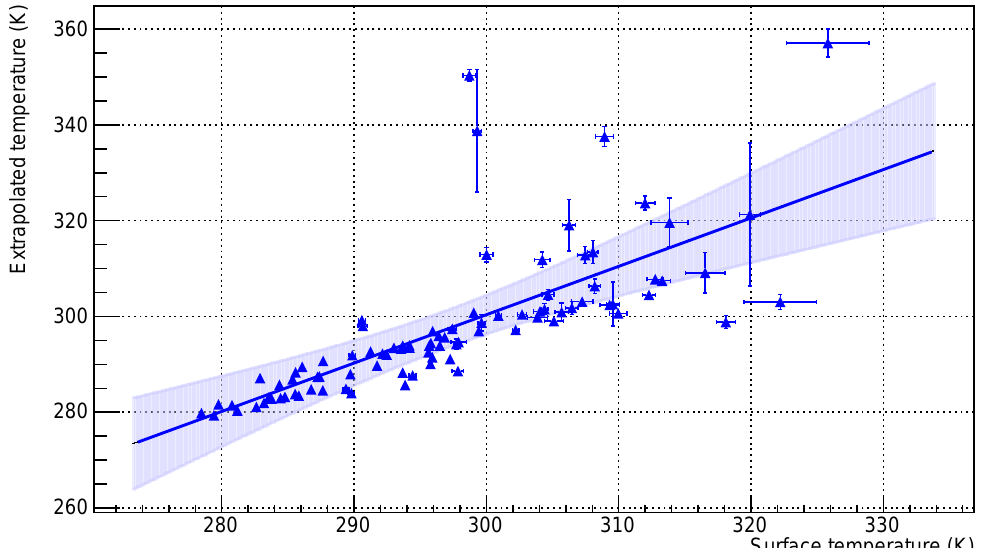
Figure 4. Comparison between surface temperatures, measured with IR camera (abscissa) and extrapolation of gradients at zero depth (ordinate) for each nightly point. The line represents the best fit of the dataset with a linear model. Results of the fit give values of − 3 ± 30 K for the intercept and 1.01 ± 0.10 for the angular coefficient; the correlation factor is about 0.8 over 91 points. The light blue band represents fit limit at 95% Confidence Level